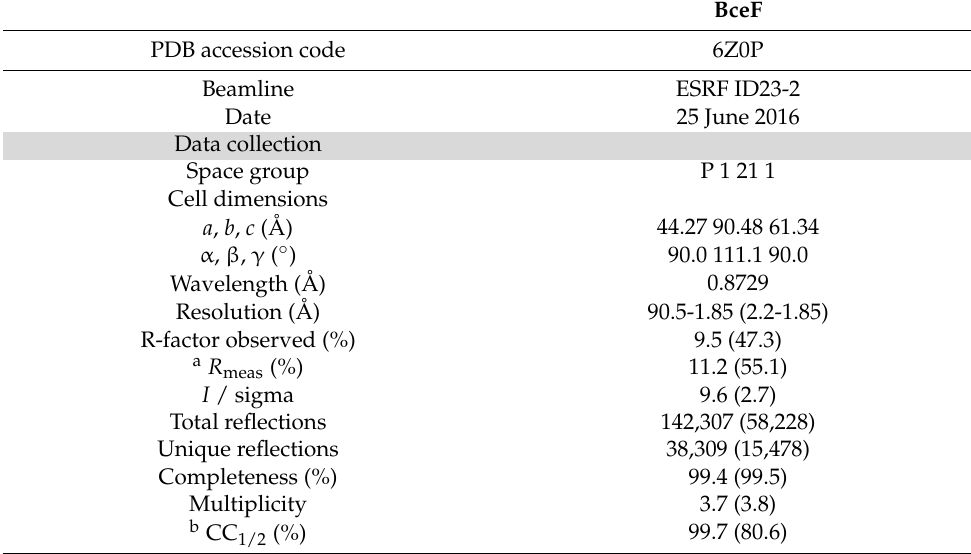
Figure 2. Conformational variability of the ADP-proximal residue Arg590 in BceF and its equiva- lent positions in other BY-kinases. ADP is present in both BceF chains, and CapAB (PDB Ids 3BFV, 2VED and 4JLV). ADP carbons are colored the same as the backbone of the protein from the same determined structure. The figure depicts a structural superimposition of the kinase domain of sev- eral BY-kinases, and of the two chains in the asymmetric unit in the crystal structure of BceF, with zoom-in into the ADP ligand and into the Arg590 residue in BceF and the equivalent positions in the other BY-kinases, shown as sticks. Side-chain atoms are colored by atom types (nitrogen in blue, oxygen in red and sulfur in yellow). The backbone and carbon atoms in each BY-kinase and